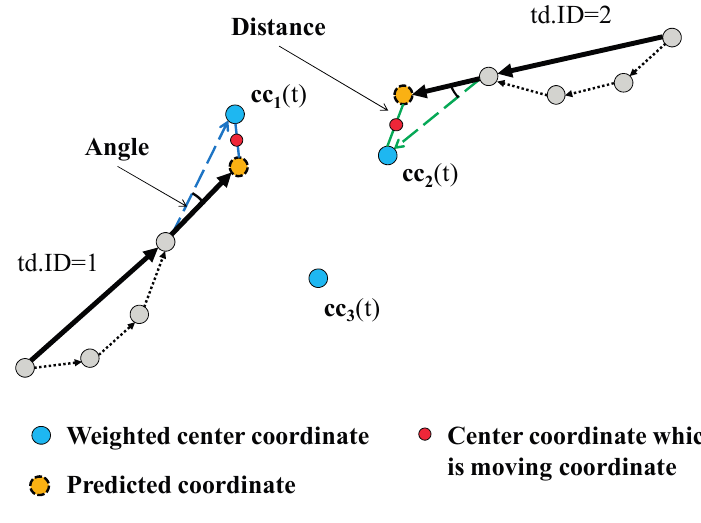
Figure 8. Example of